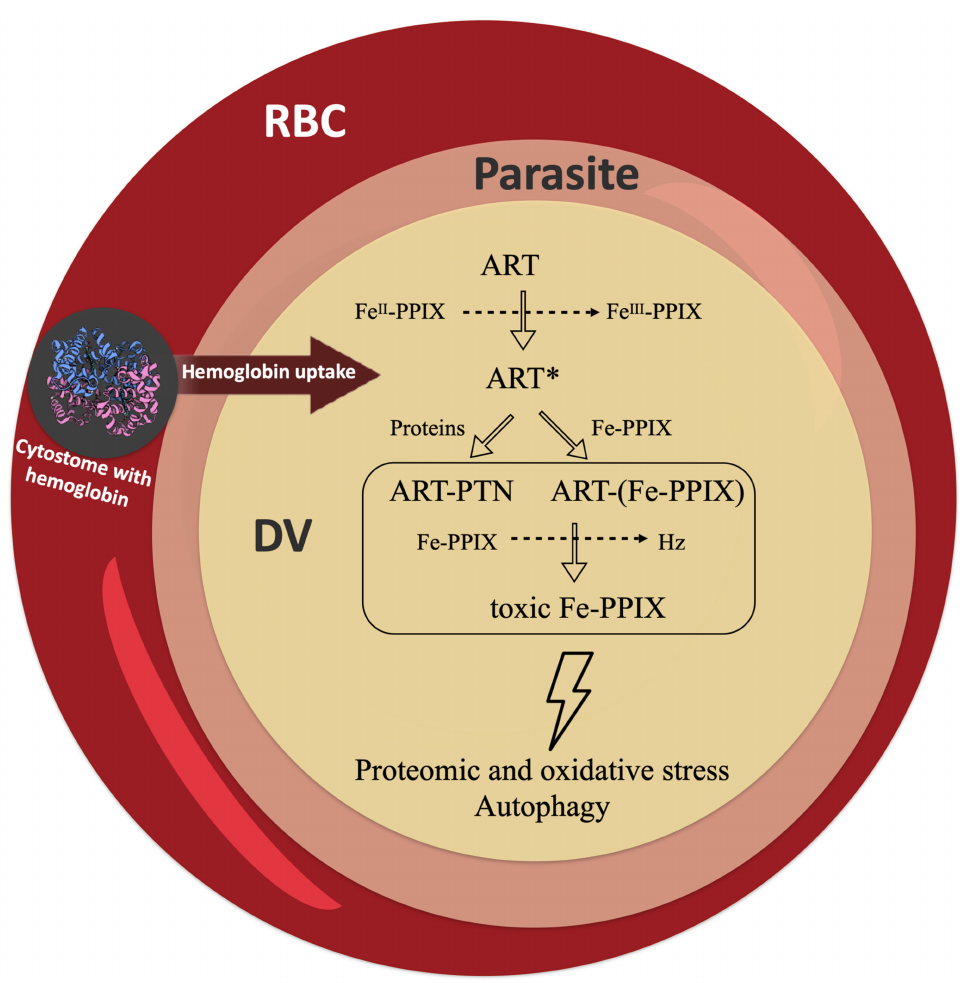
Figure 6. Potential pathways for the radical-induced alkylation of proteins and heme. Artemisinin (ART) is activated by heme into a radical species (ART*). This can alkylate client molecules, such as proteins (PTN) and iron protoporphyrin IX (Fe-PPIX). The alkylation of proteins (ART-PTN) can have an impact on the pathways of protein degradation by causing proteomic stress, autophagy, and other effects. The alkylation of heme [ART-(Fe-PPIX)] can suppress heme detoxification, leading to a buildup of toxic Fe-PPIX and causing oxidative stress, autophagy, and other effects. RBC = red blood cell; DV = digestive